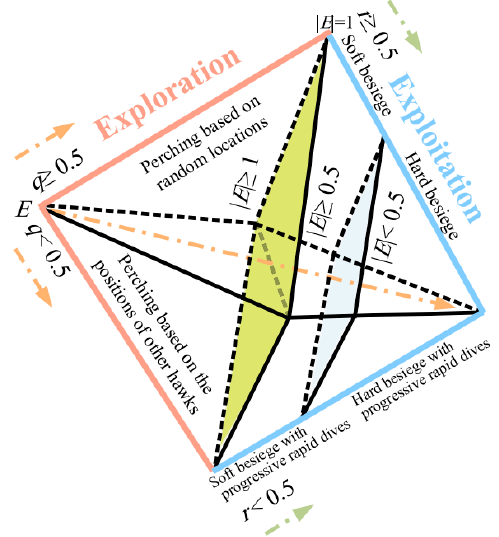
Figure 5. Different phases of Harris hawks optimization (after Heidari et al. [48]). Figure 5. Di ff erent phases of Harris hawks optimization (after Heidari et al.